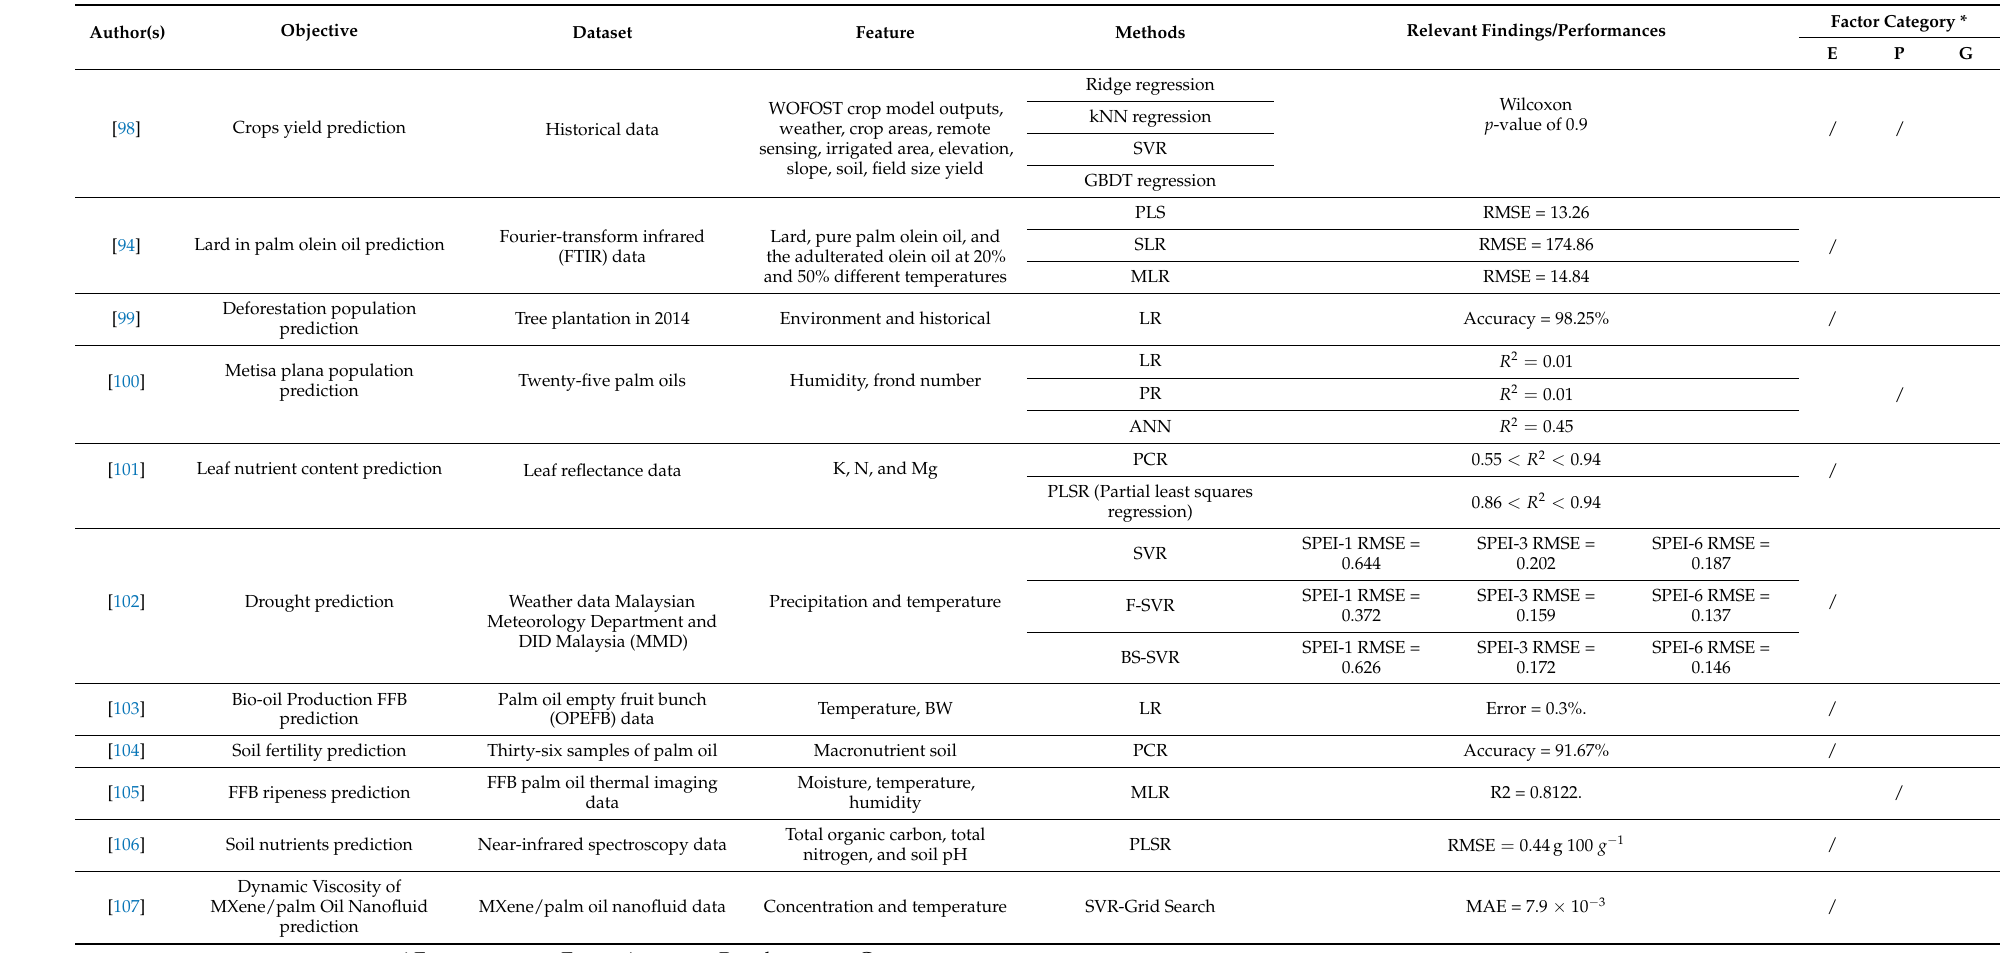
Table 4. Regression prediction of crops and palm